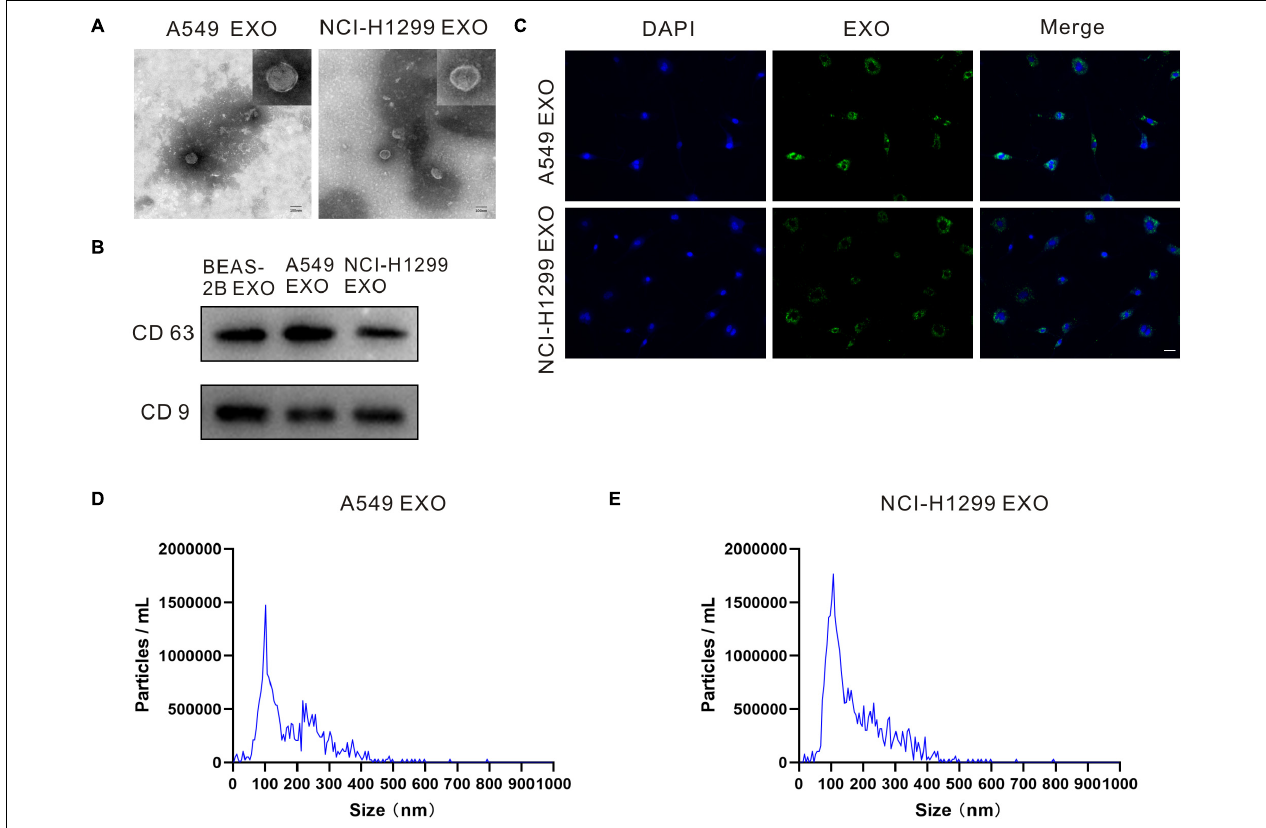
FIGURE 1 | Characterizations of exosome morphology and specificity. (A) Representative electron micrographs of exosomes isolated from A549 and NCI-H1299 cells conditioned medium revealing the typical morphology and size. Scale bar represents 100 nm. (B) Western blot analysis showing abundant CD63 and CD9 in exosomes derived from the medium of A549 and NCI-H1299 cells. (C) The uptake of DRG cells after adding PKH67-labeled exosomes derived from A549 and NCI-H1299 cells. Images were taken 24 h after exosome addition by confocal microscope. Scale bar represents 50 µ m. (D,E) Size distributions of A549 and NCI-H1299 exosomes were quantified using nanoparticle tracking analysis (NTA). All experiments were performed three times.